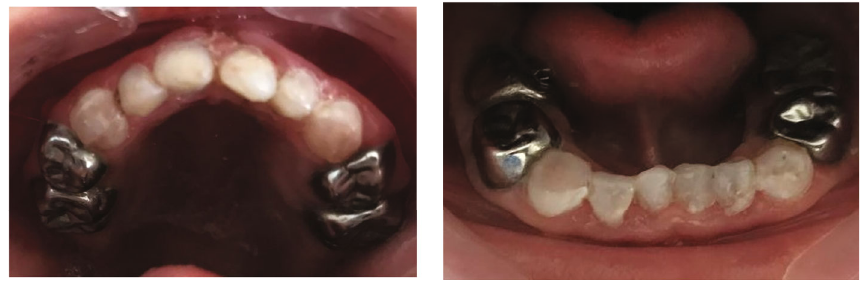
Figure 3: Postoperative restorative